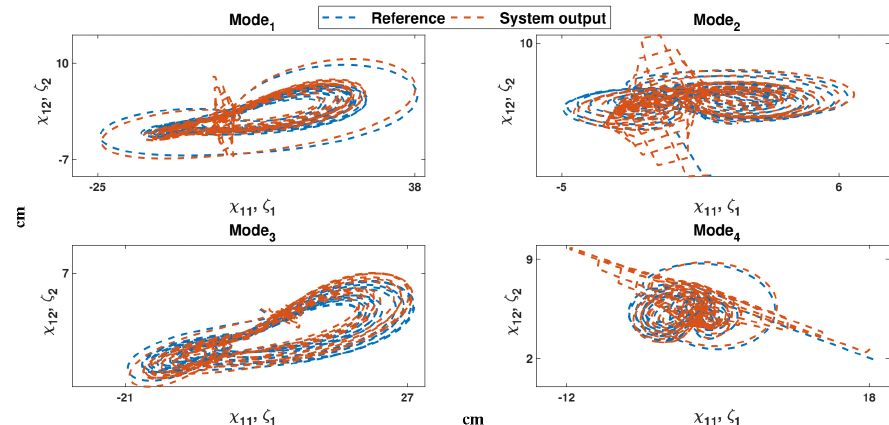
Figure 9. The phase